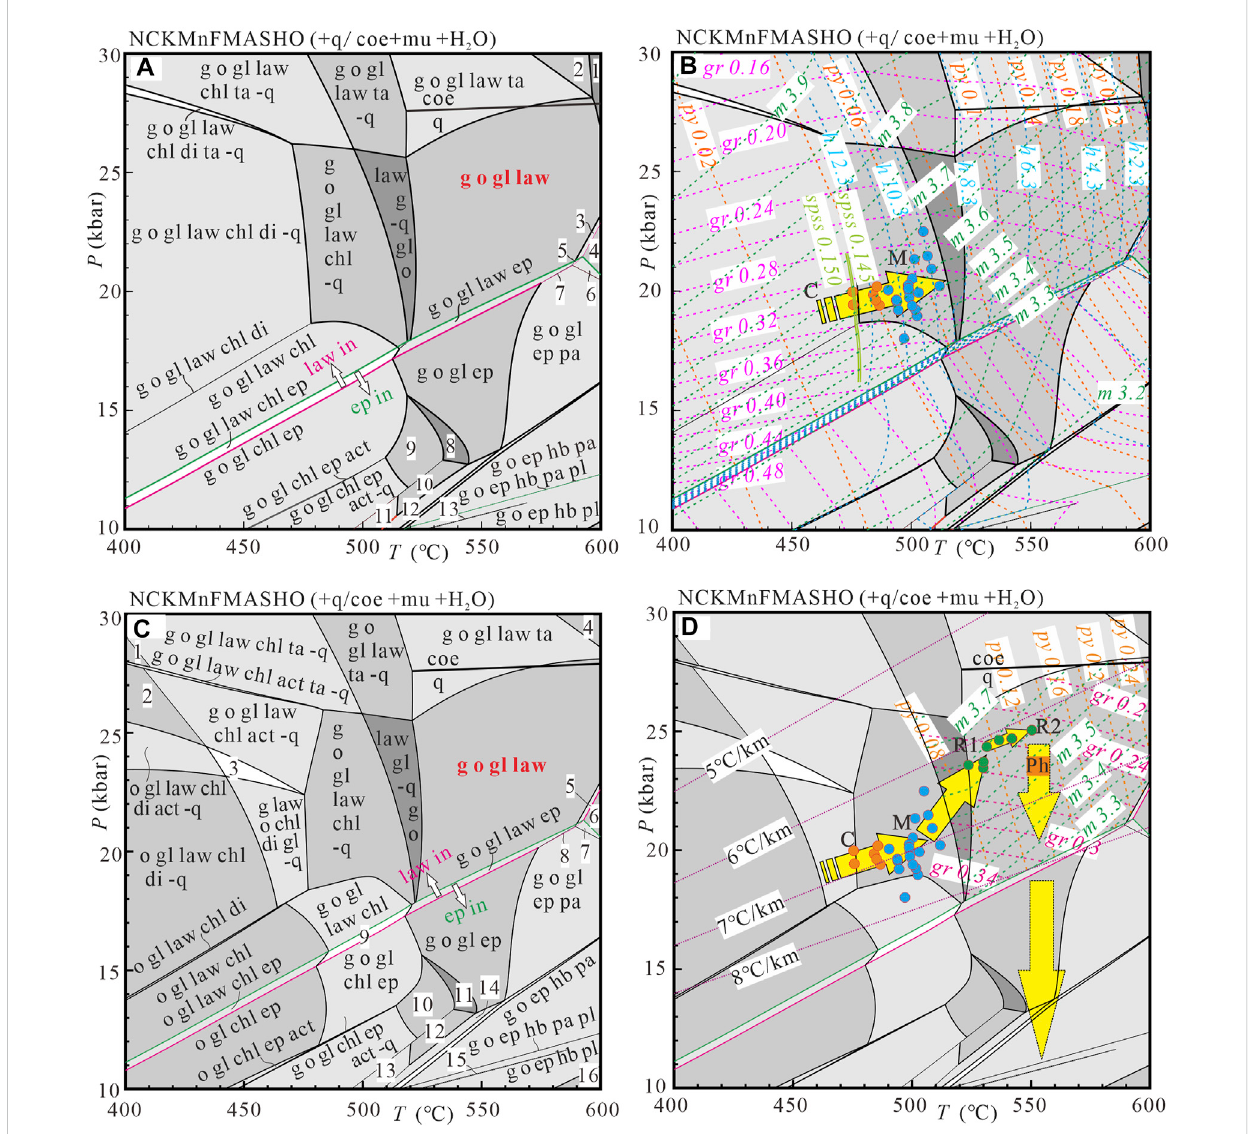
FIGURE 7 P – T pseudosections for the eclogite GQ – 2 using primary bulk rock composition (A,B) and effective bulk rock composition (C,D) in Table 4. In (A) , thenumberrepresents:1.golaw,2.golawta,3.gogllawky,4.goglky,5.gogllawepky,6.goglepky,7.gogllaweppa,8.goglep-q,9.goglchlep -q,10.goglephb-q,11.goglepacthb-q,12.goglephb,13.goephbpldi.In (C) ,thenumberrepresents:1.ogllawchlta-q,2.ogllawchlact-q,3.go